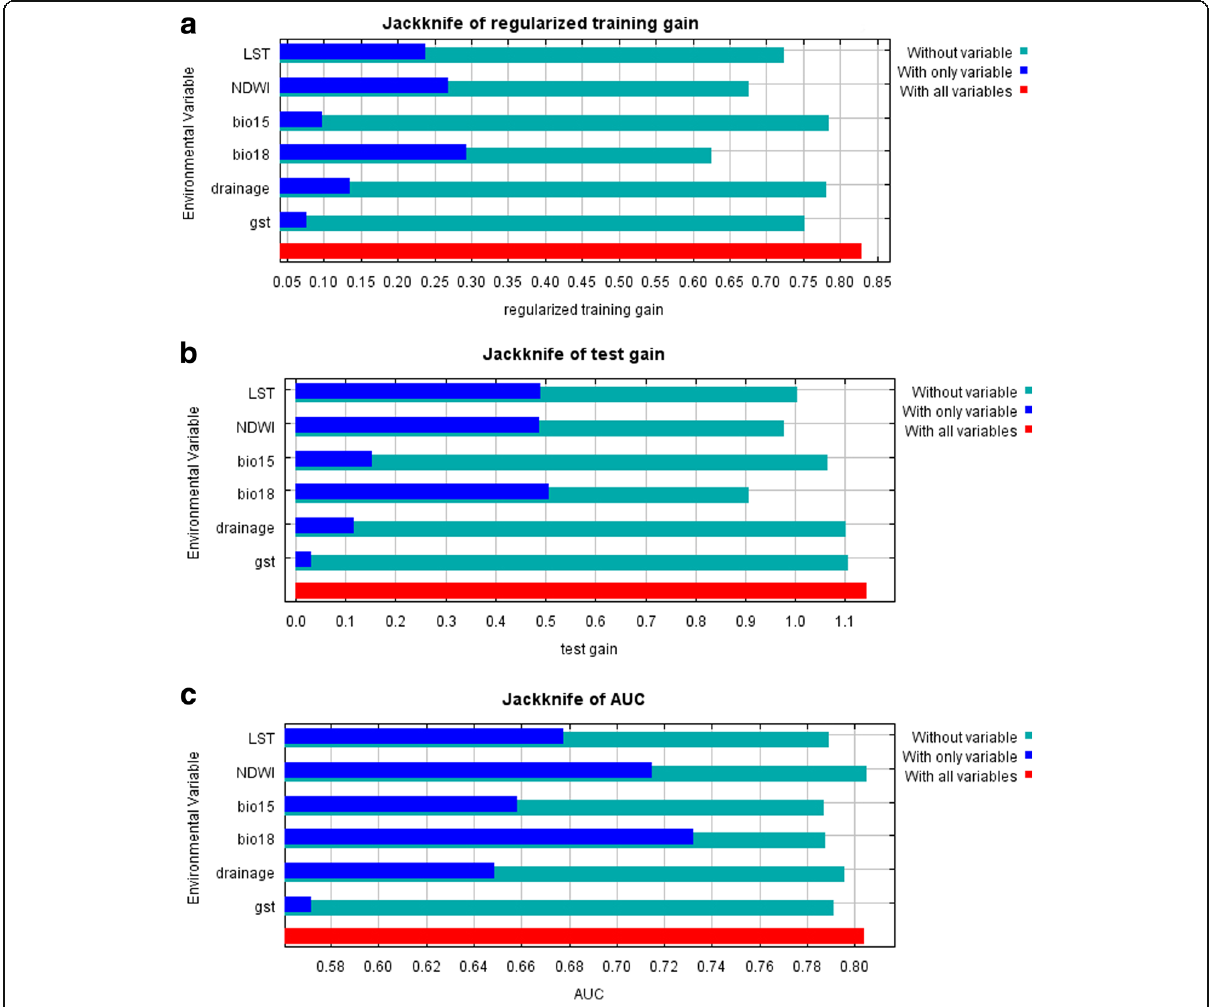
Fig. 3 Jackknife test of variable importance in the ENM. a Training gain. b Test gain. c Test